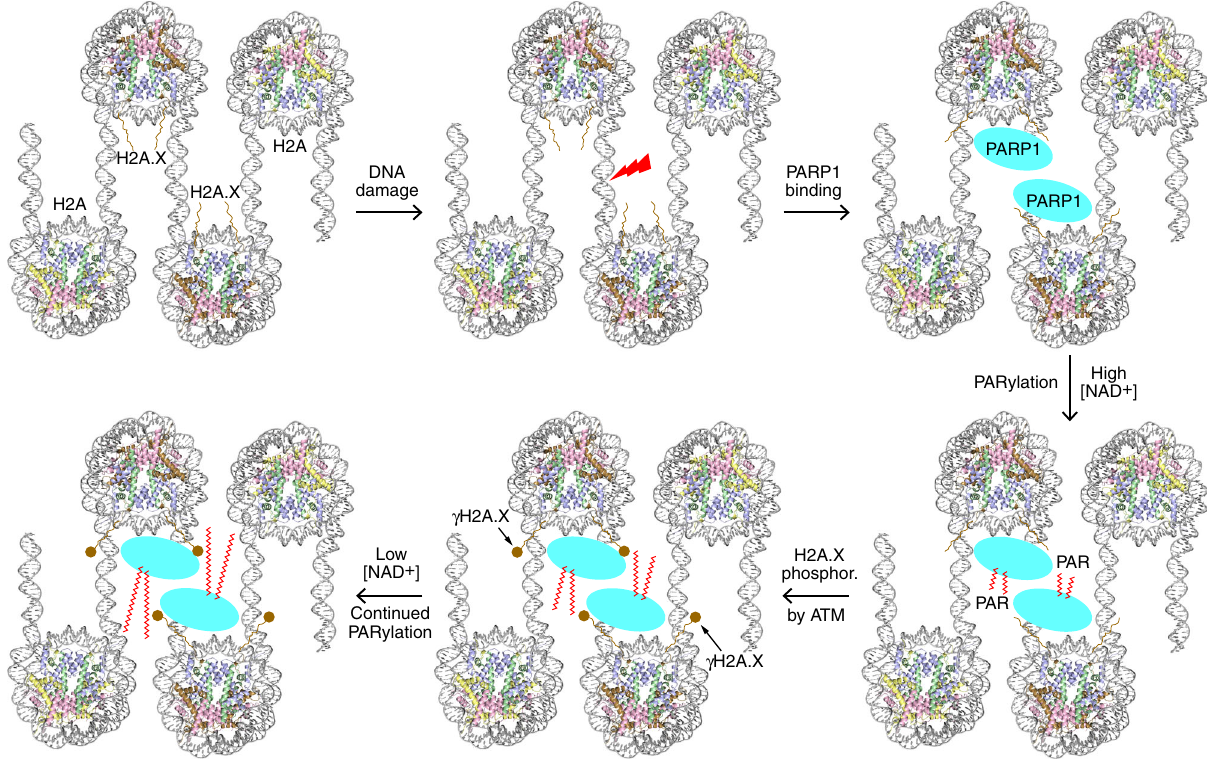
Fig. 6 Model for the contribution of H2A.X nucleosomes towards PARP1-mediated DNA repair. A DNA damage hotspot is demarcated by H2A.X deposition. Subsequent to a double helix breakage event, PARP1 rapidly associates with the H2A.X-nucleosomal DSBs at high af fi nity. This ensures prompt activation of PARP1, initiating PARylation, and H2A.X is subsequently phosphorylated to γ H2A.X, which further stabilizes the assembly. Even as the NAD + concentration drops to low levels, the in fl uence of γ H2A.X supports continued